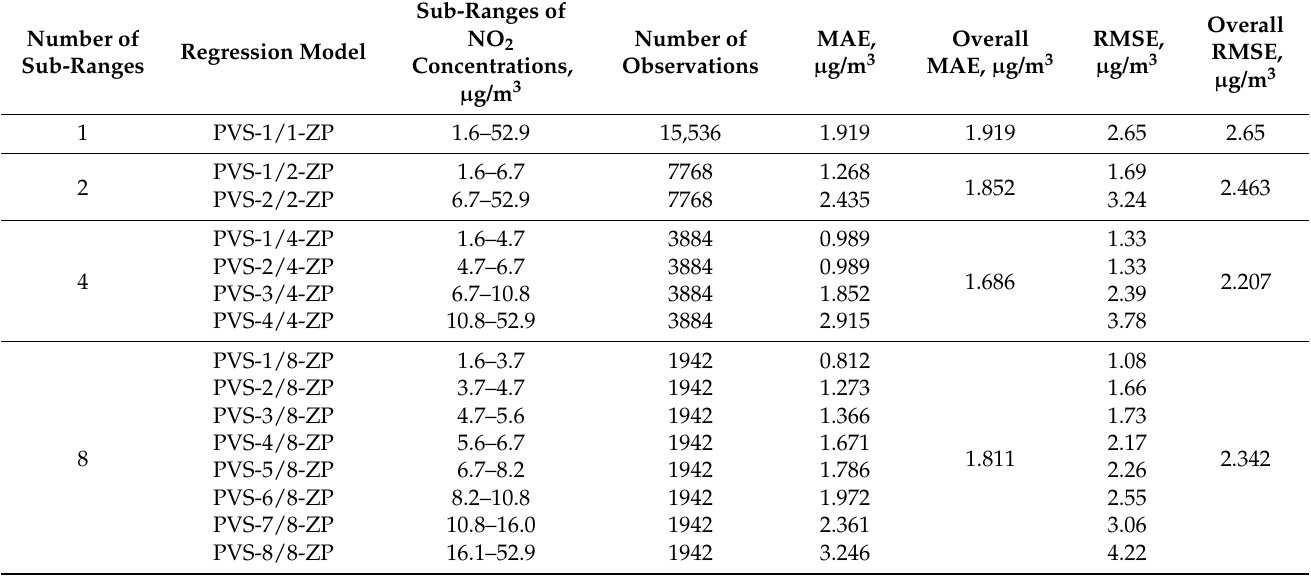
Table 12. Values of approximation errors of NO 2 concentrations in PVS models, Złoty Potok 2011–